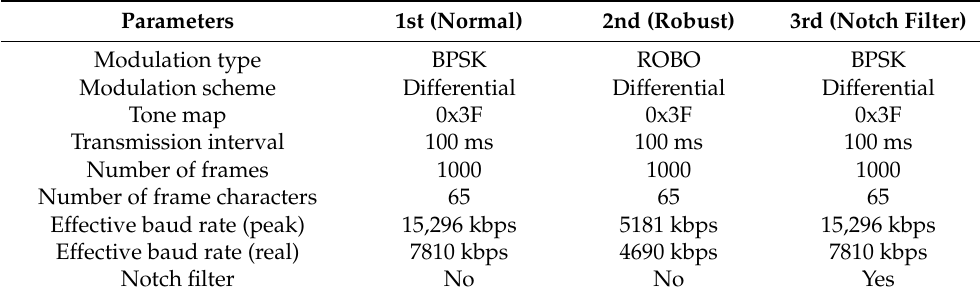
Table 3. Transmission session